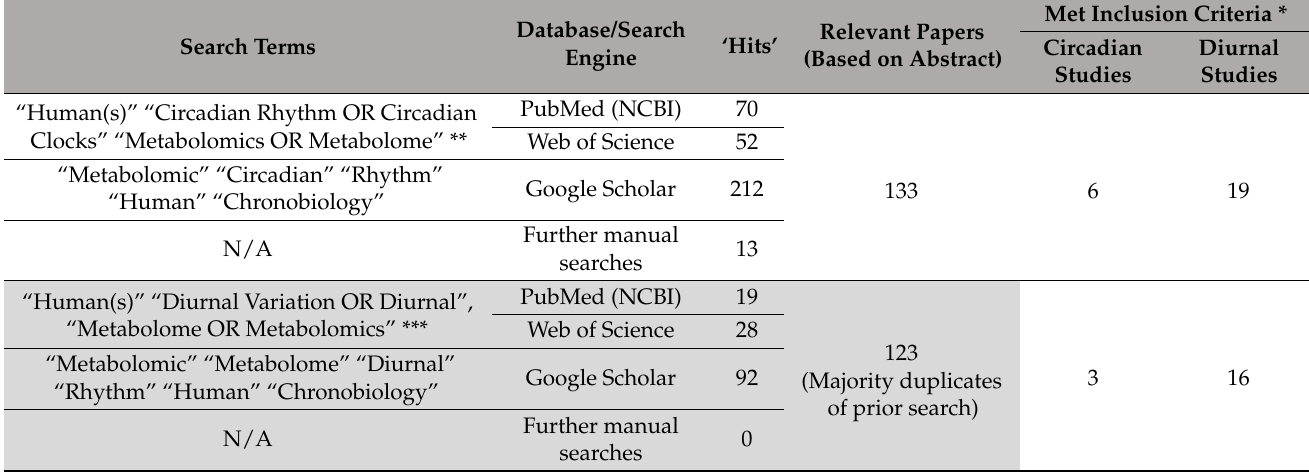
Table 1. Summary of literature search parameters and outcomes. Two separate searches were performed, with the first search featuring ‘circadian’ as a key word (performed circa 21 April 2020) and the second search featuring ‘diurnal’ in lieu of circadian (highlighted—light grey, performed circa 23 July 2020). The two searches were performed to encompass as much literature as possible observing daily rhythms. On the first search, the search terms had to be reduced when using Google Scholar due to insufficient ‘hits’ ( n = 1 ‘hits’) resulting from excess search terms. Reduced hits on the second search when using the phrases ‘diurnal’/’diurnal variation’ may stem from neither term corresponding to MeSH terms (for PubMed) and potentially being uncommon key words associated with literature from other search engines reducing discoverability. Manual searches consisted of looking for prior referenced work in collected literature that met inclusion criteria. Met Inclusion Criteria * Database/Search Relevant Papers ‘Hits’ Search Terms Circadian Engine (Based on Abstract) Studies